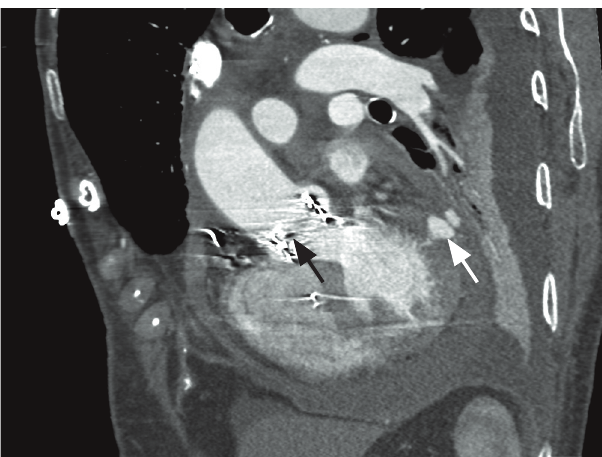
Fig. 2. Sagittal CT reconstruction of the thorax showing the implanted aortic valve. The left ventricle free wall defect with small pseudoaneurysm is also again